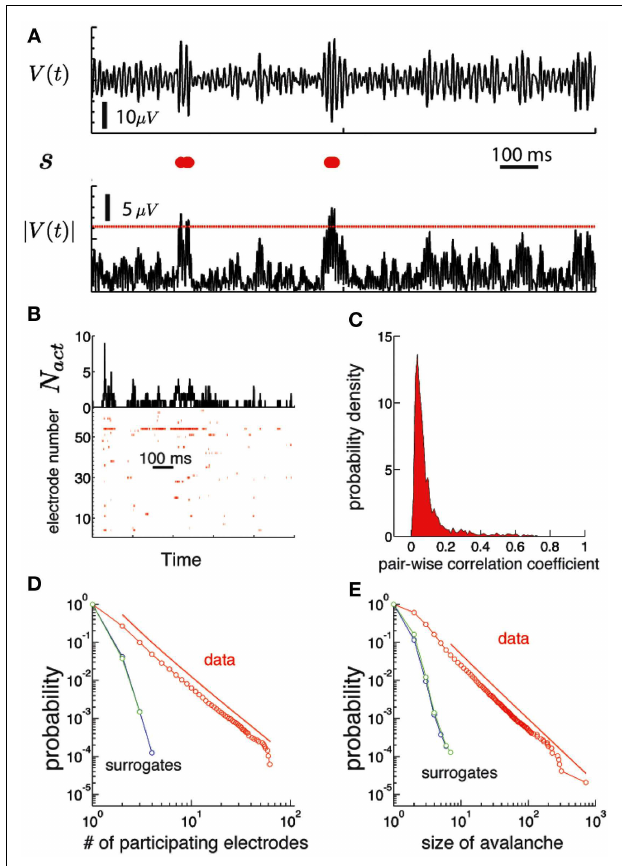
FIGURE 3 | Human brain ECoG potentials are statistically critical. (A) The procedure used to obtain the binary version of the ECoG potential avalanches is illustrated for one channel. On the top we show the trace of the electric potential at one channel, V ( t ) as a function of time during 1s. The lower black trace is the absolute value of the potential | V |.We use a threshold V th (red line) to convert this signal into a binary string s , displayed in red in the middle row. Each red dot correspond to a time step of the electric potential where | V | ≥ V th (B) bottom: Raster plot of a discretized version of the ECoG potential for an individual subject. Each red dot indicate an active electrode: i.e., the absolute value of the ECoG potential for that electrode (ordinate) is above a threshold at that time (abscissa).The threshold was set to 3.5 SD, where SD is the mean standard deviation, averaged over all electrodes.Top: the number of active electrodes ( N act ) as a function of time. An avalanche of activity is any activation event separated by regions of N act = 0. (C) Histogram of the linear pair-wise correlation coefficient (Pearson) calculated between all pairs of binary sequences corresponding to the activation of each electrode. (D) The number of unique electrodes that participate in the avalanche (1, ... , N e ) are power law distributed (red).The red line is a power-law fit of the data (shifted for clarity). Both simulated signals do not show a power-law distribution. (E) The size of the avalanches is also power law distributed (see Figure 4 to see the results for all